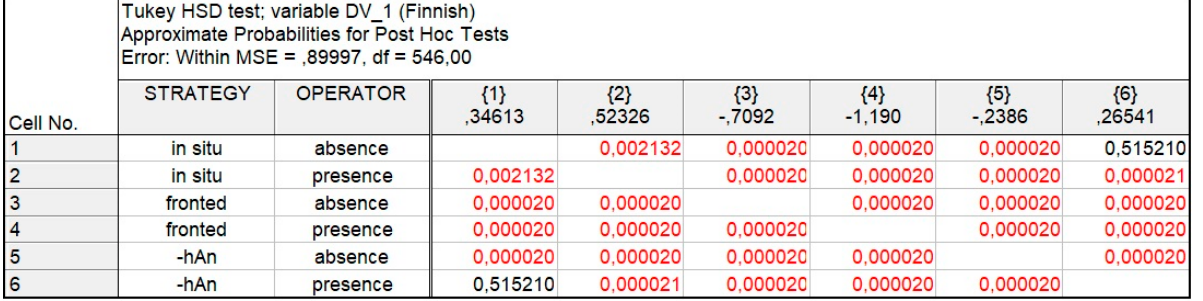
Figure 12. Strategy*Operator post hoc results (Finnish) .